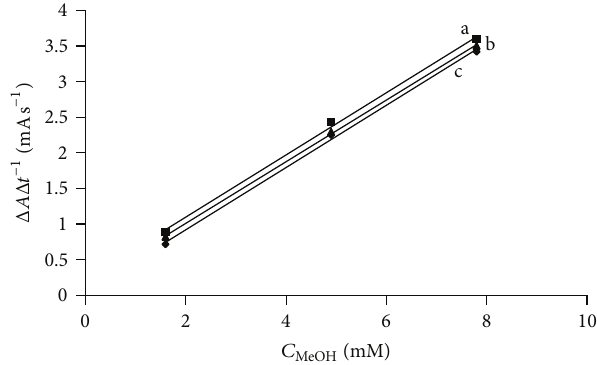
Figure 2: Alcohol oxidase (AOX) concentration influence on the analytical signal-reaction rate. a: AOX concentration: 2.5 UmL −1 (8.8 ± 0.2) × 𝑡 ( s ) + (198 ± 25) , 𝑟 = 0.99 , b: AOX concentration: 2 UmL −1 (8.0±0.1)×𝑡 ( s )+(13±1)×10 , 𝑟 = 0.997 ,